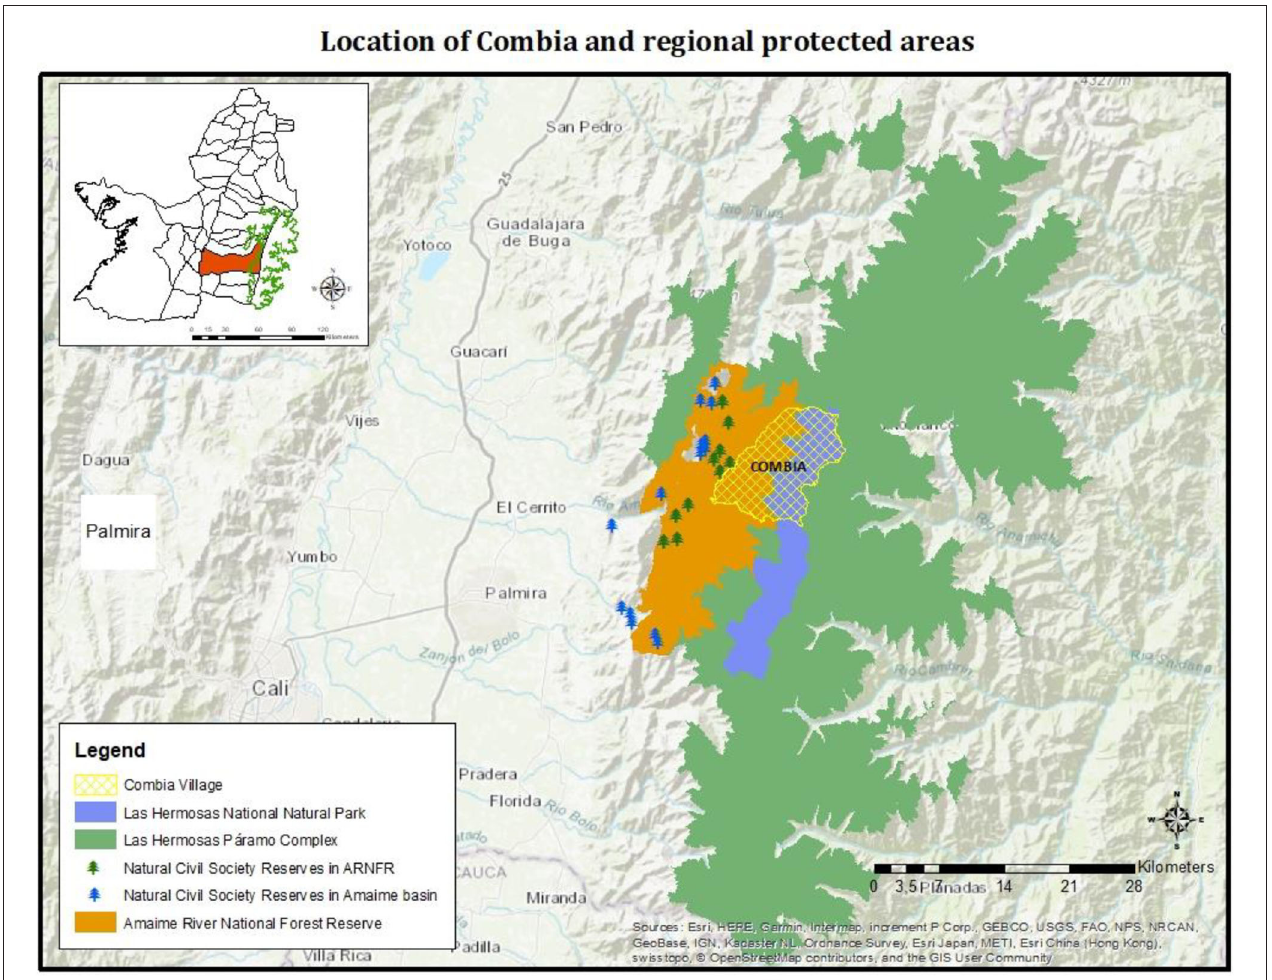
FIGURE 2 | Combia is in the northeast of the Palmira municipality. Own creation based on cartographic information by Corporación Autónoma Regional del Valle del Cauca (2019)